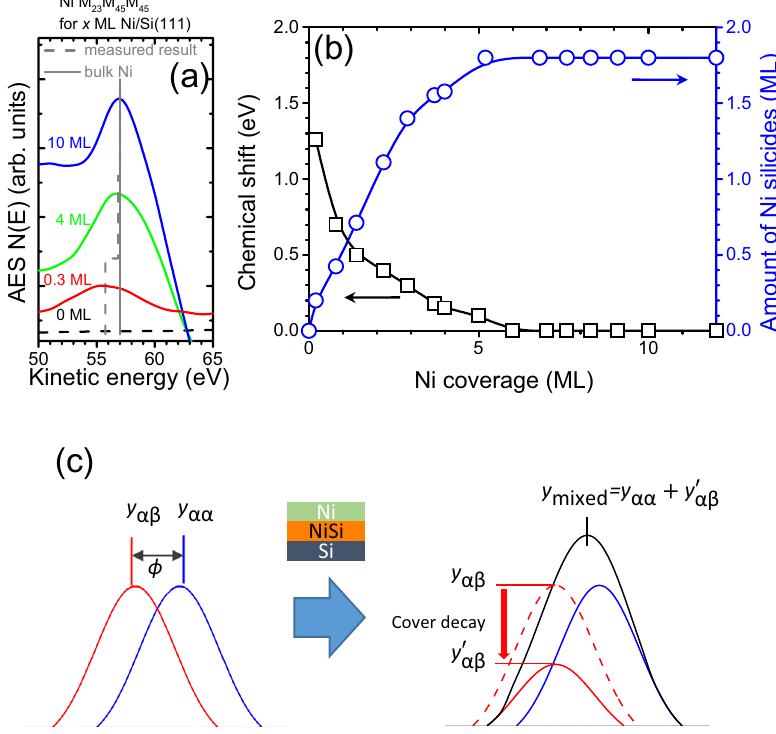
Figure 3. ( a ) Auger signals N ( E ) near the Ni M 23 M 45 M 45 Auger transition versus kinetic energy for 0, 0.3, 4 and 10 ML Ni/Si(111). ( b ) Chemical shift (black squares) and amount of Ni silicides (blue circles) versus Ni coverage for Ni/Si(111) thinner than 12 ML. ( c ) Schematic plots for simulated Auger peaks by assuming α - α and α - β bonds with a layered